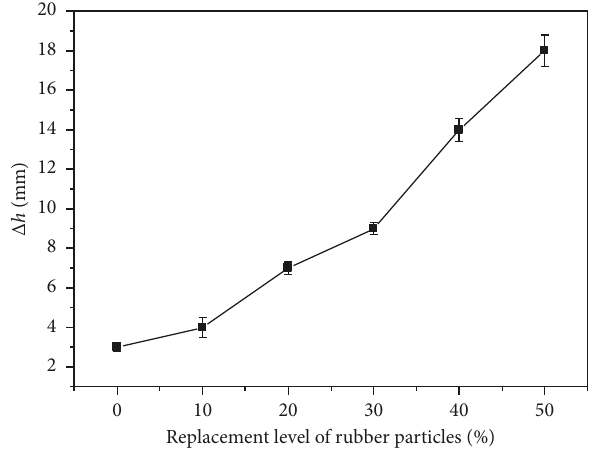
Figure 17: Influence of the replacement level of rubber particles on Δ h .